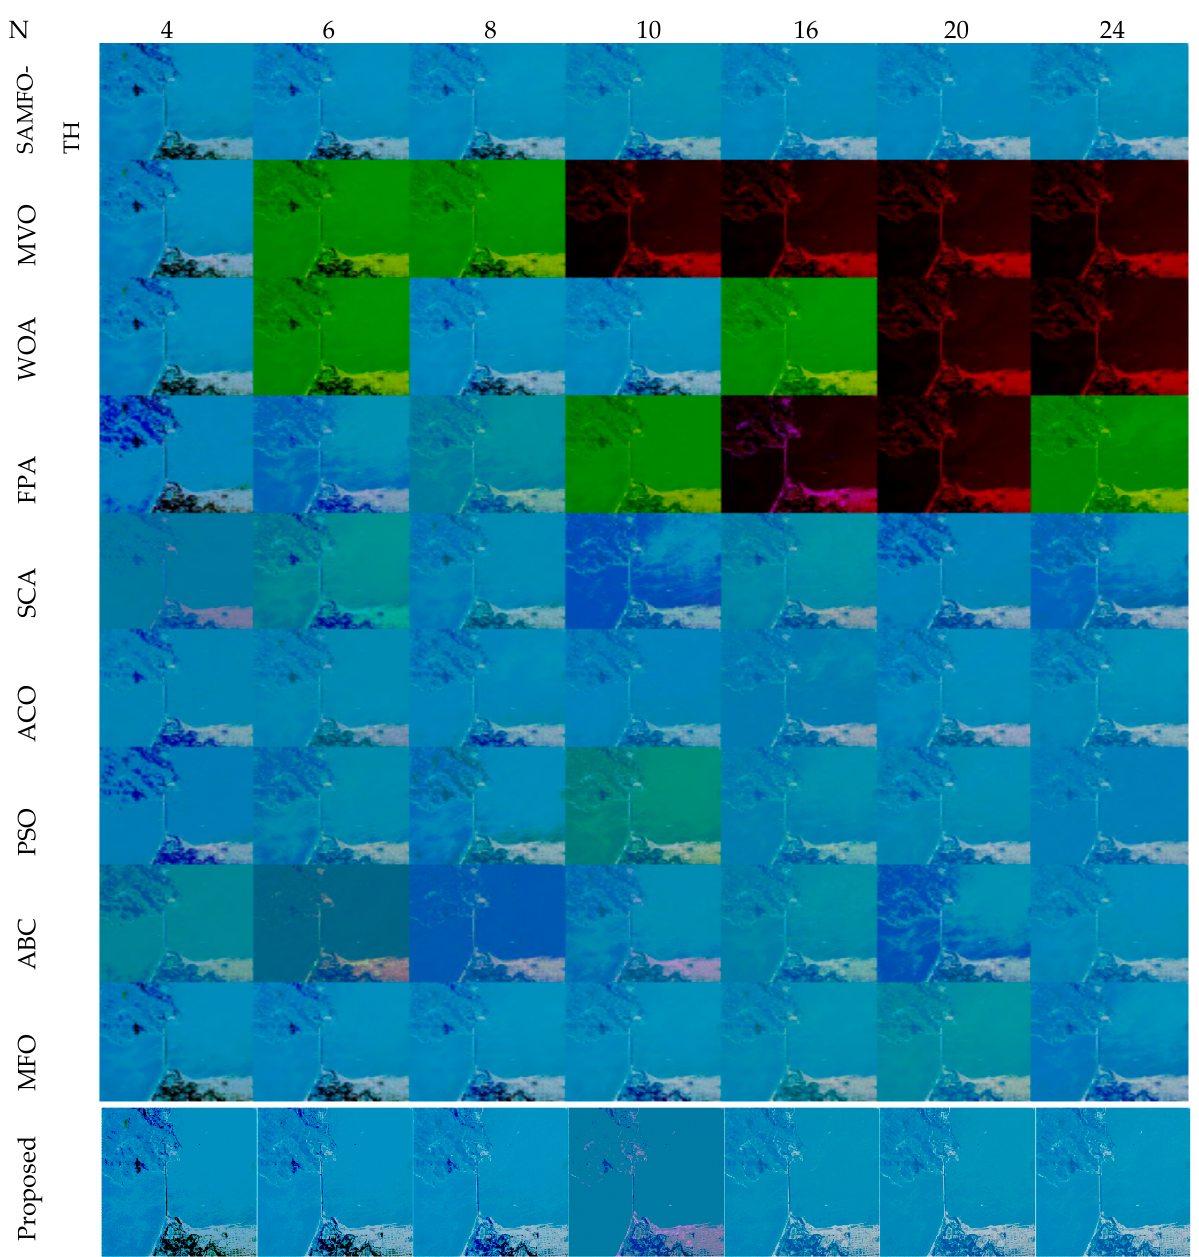
Figure 7. Segmented images of Image 7 at N = 4, 6, 8, 10, 16, 20, and 24, using SAMFO-TH, MVO, WOA, FPA, SCA, ACO, PSO, ABC, and MFO, and with the proposed model based on Otsu’s method.